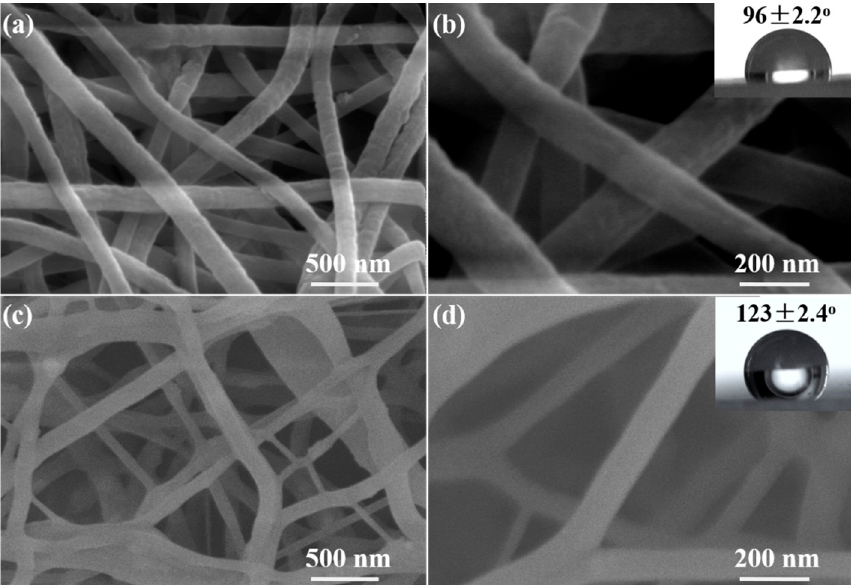
Figure 1. Scanning electron microscopy (SEM) images with different magnification of ( a , b ) PU-0, ( c , d ) polyurethane (PU)-4 nanofibrous membrane, the insets in ( b , d ) show images of water drops and the corresponding contact angles .